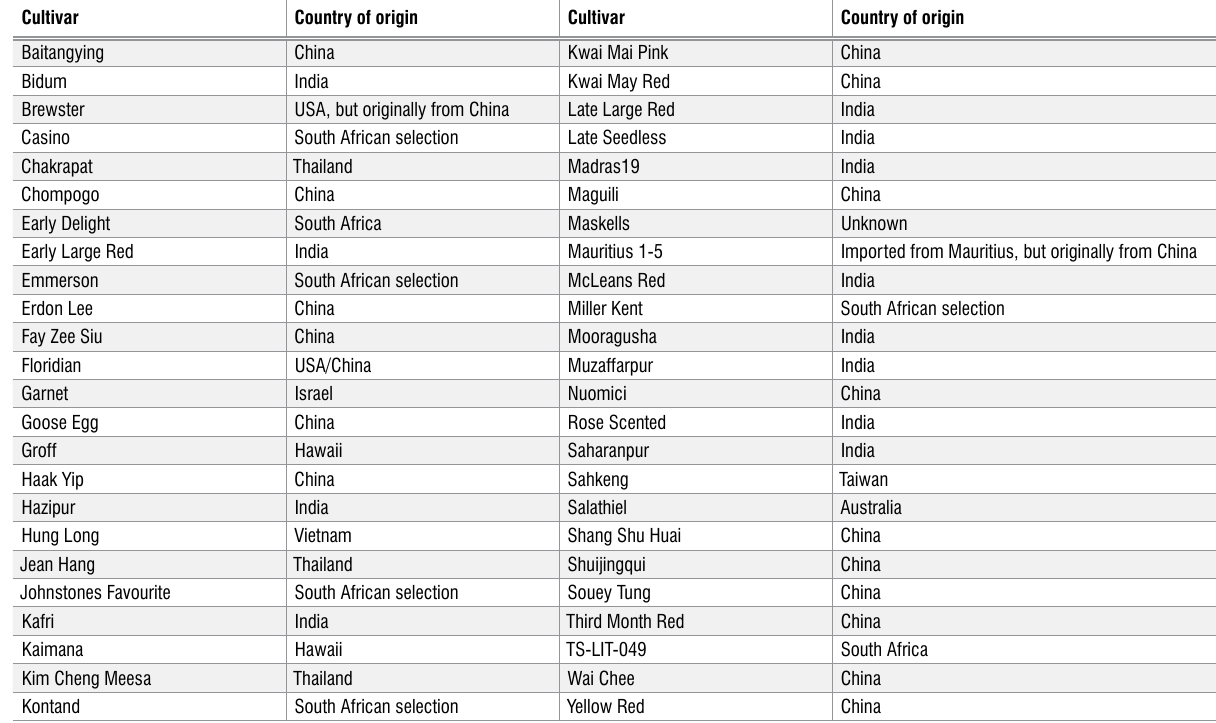
Litchi cultivars used in the current study and country of